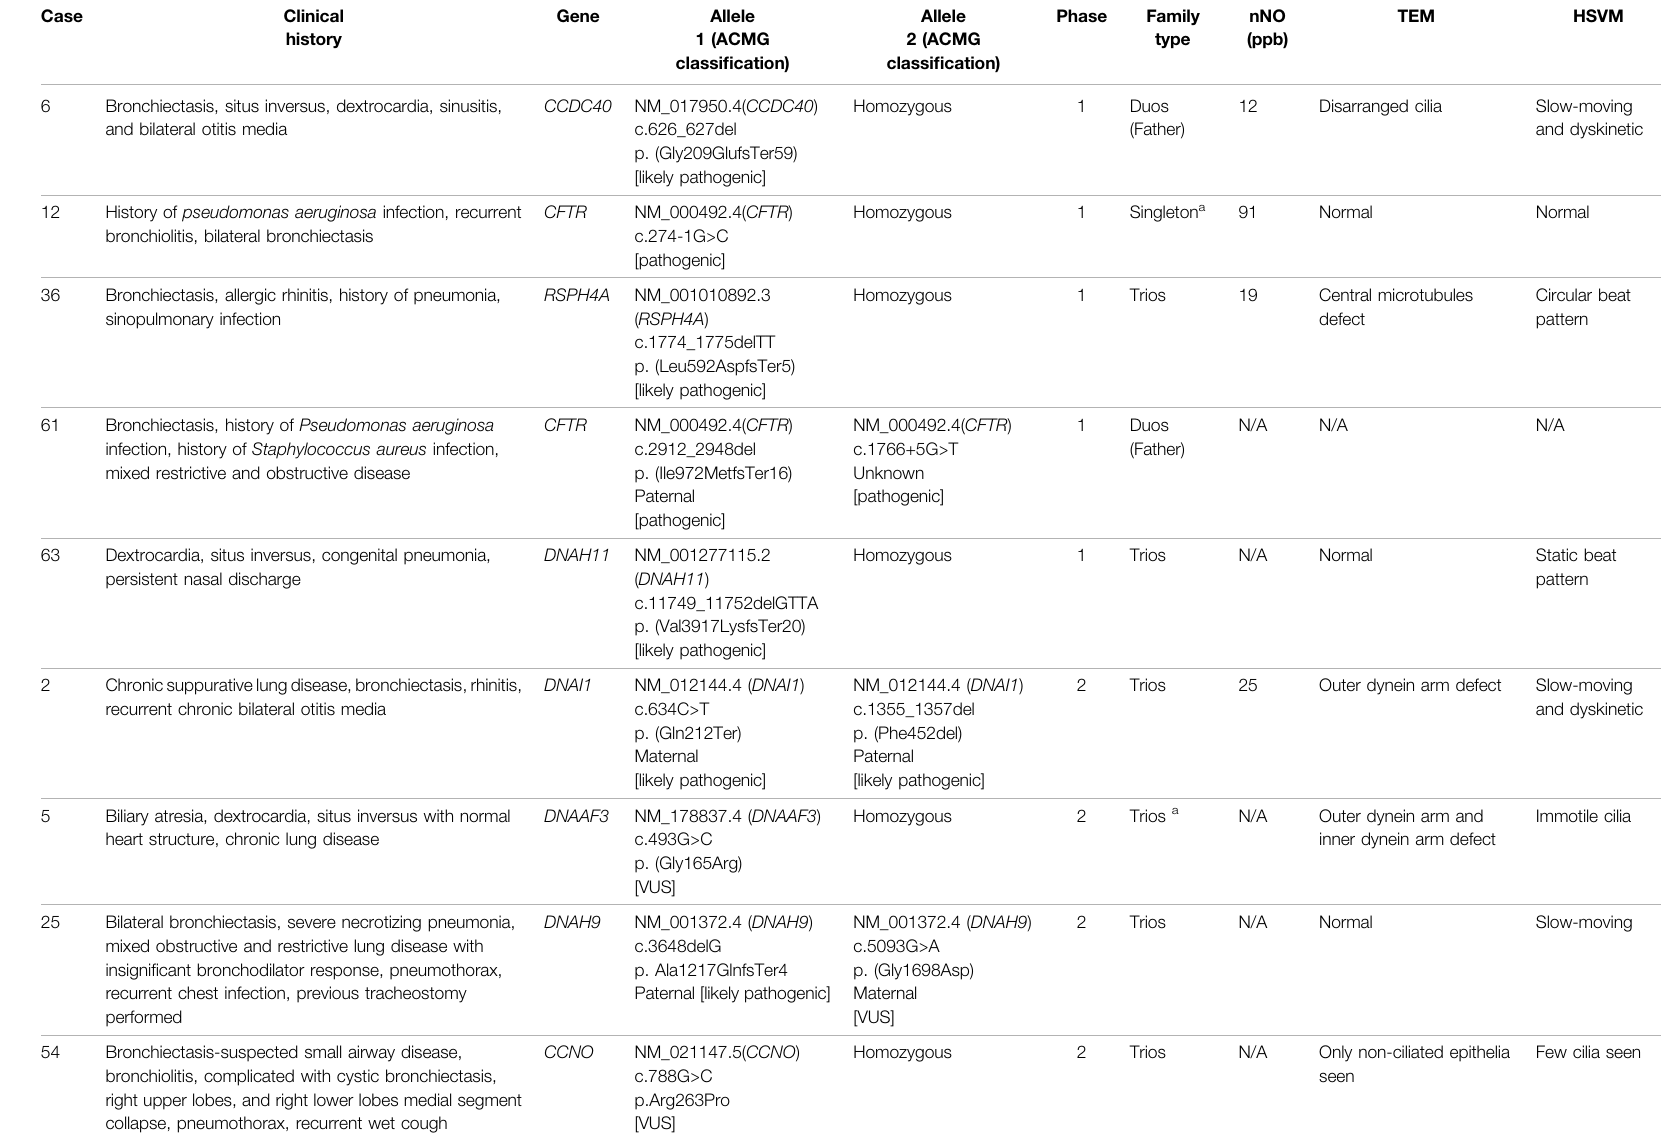
TABLE 1 | Comprehensive functional and genetic landscape of early-onset bronchiectasis patients in Hong Kong.